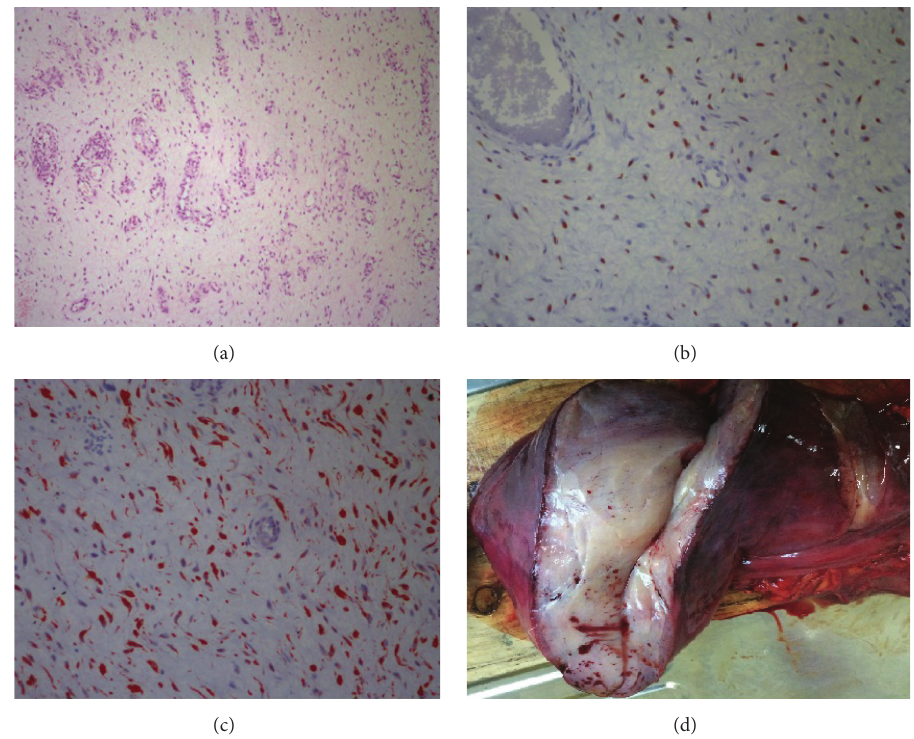
Figure 3: Histopathologic examination of the tumor. (a) Spindled and stellate-shaped cells in a myxoid and richly vascular background (H&E × 100). (b) Estrogen receptor immunoreactivity in aggressive angiomyxoma (H&E × 400). (c) Diffuse desmin immunoreactivity in aggressive angiomyxoma (H&E × 400). (d) Macroscopic imaging of the